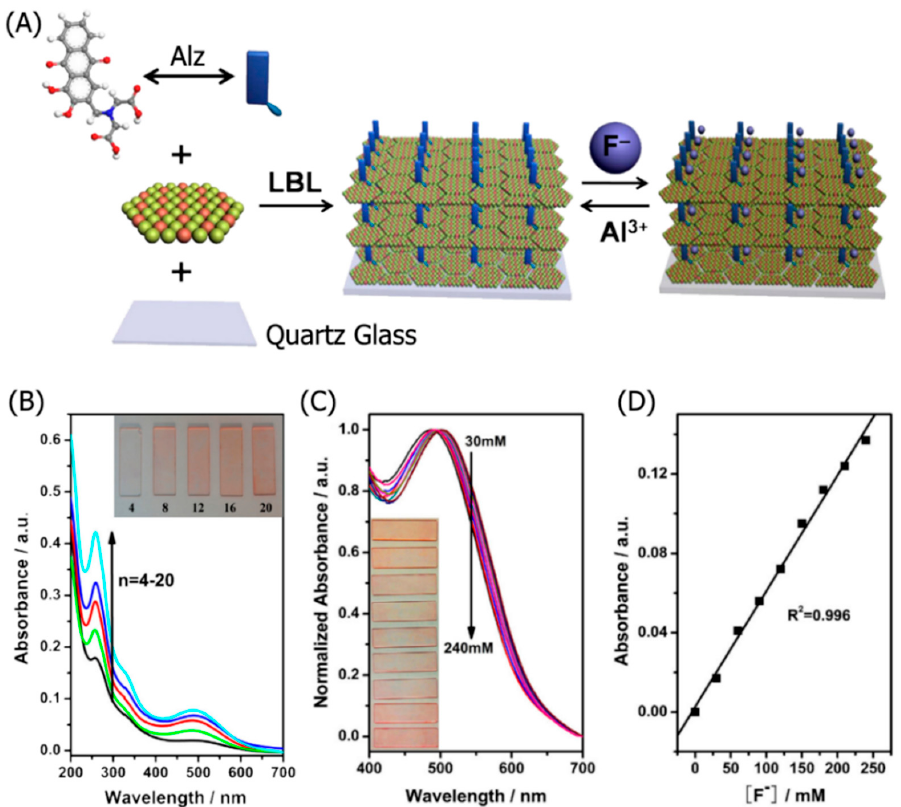
Figure 3. ( A ) Schematic of Mg 2 Al-LDH/Alz optical sensor fabrication and F − adsorption for optical detection; ( B ) change in absorbance for the LDH/Alz sensor with an increasing number of bilayers from 4 to 20; ( C ) bathochromic shift in peak absorbance with increasing F − concentration from 30 to 240 nM; and ( D ) the linear calibration curve of F − concentration based on the change in absorbance at 550 nm for as a function of F - concentration for the MgAl 2 -LDH/Alz sensor with 20 layers, reproduced from reference [111] with permission from Elsevier, 2013.